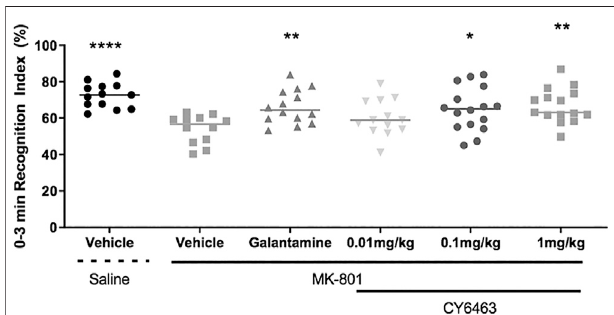
FIGURE 5 | Recognition index of the 0- to 3- min interval. MK-801 caused a strong memory de fi cit and galantamine, 0.1 mg/kg CY6463